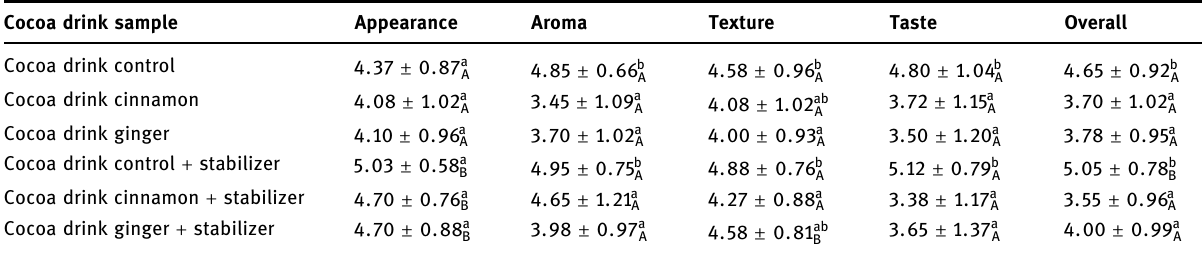
Table 2: Panelists ’ hedonic response of cocoa drinks formulated with ginger, cinnamon powder and stabilizer Cocoa drink